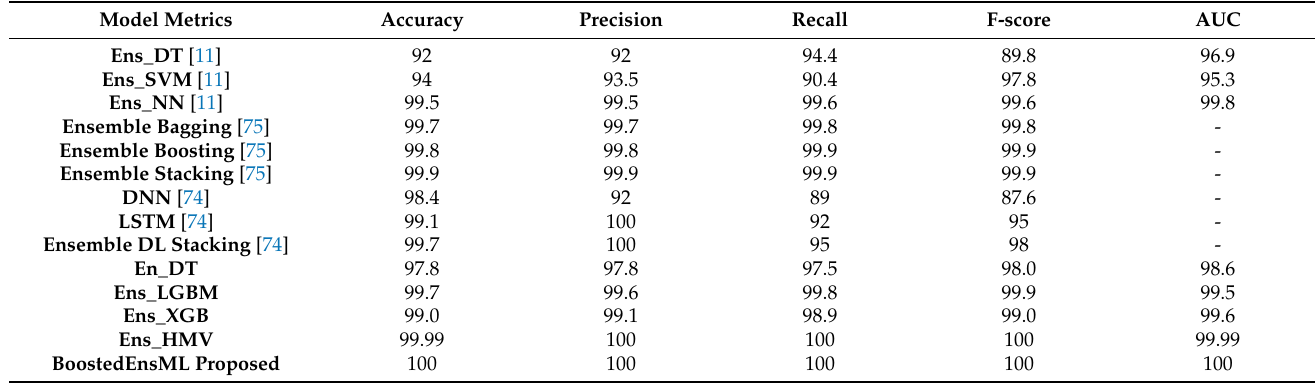
Table 9. Comparison of our ensemble models with other state-of-the-art ensembles. Model Metrics